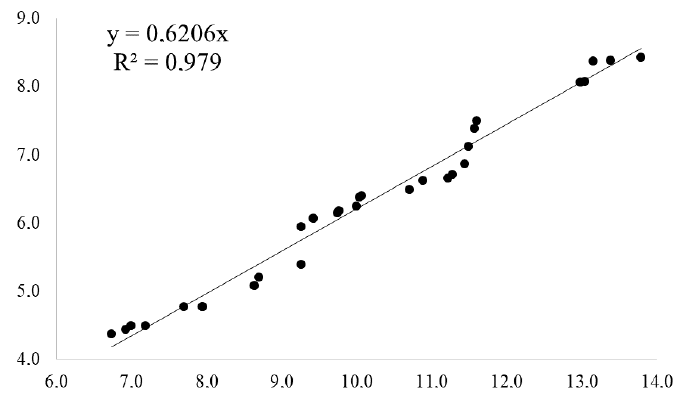
Figure 6. Simple regression equation between the area of the H. serratifolius leaves and the product of their dimensions, resulting in a correction factor of 0.6206.